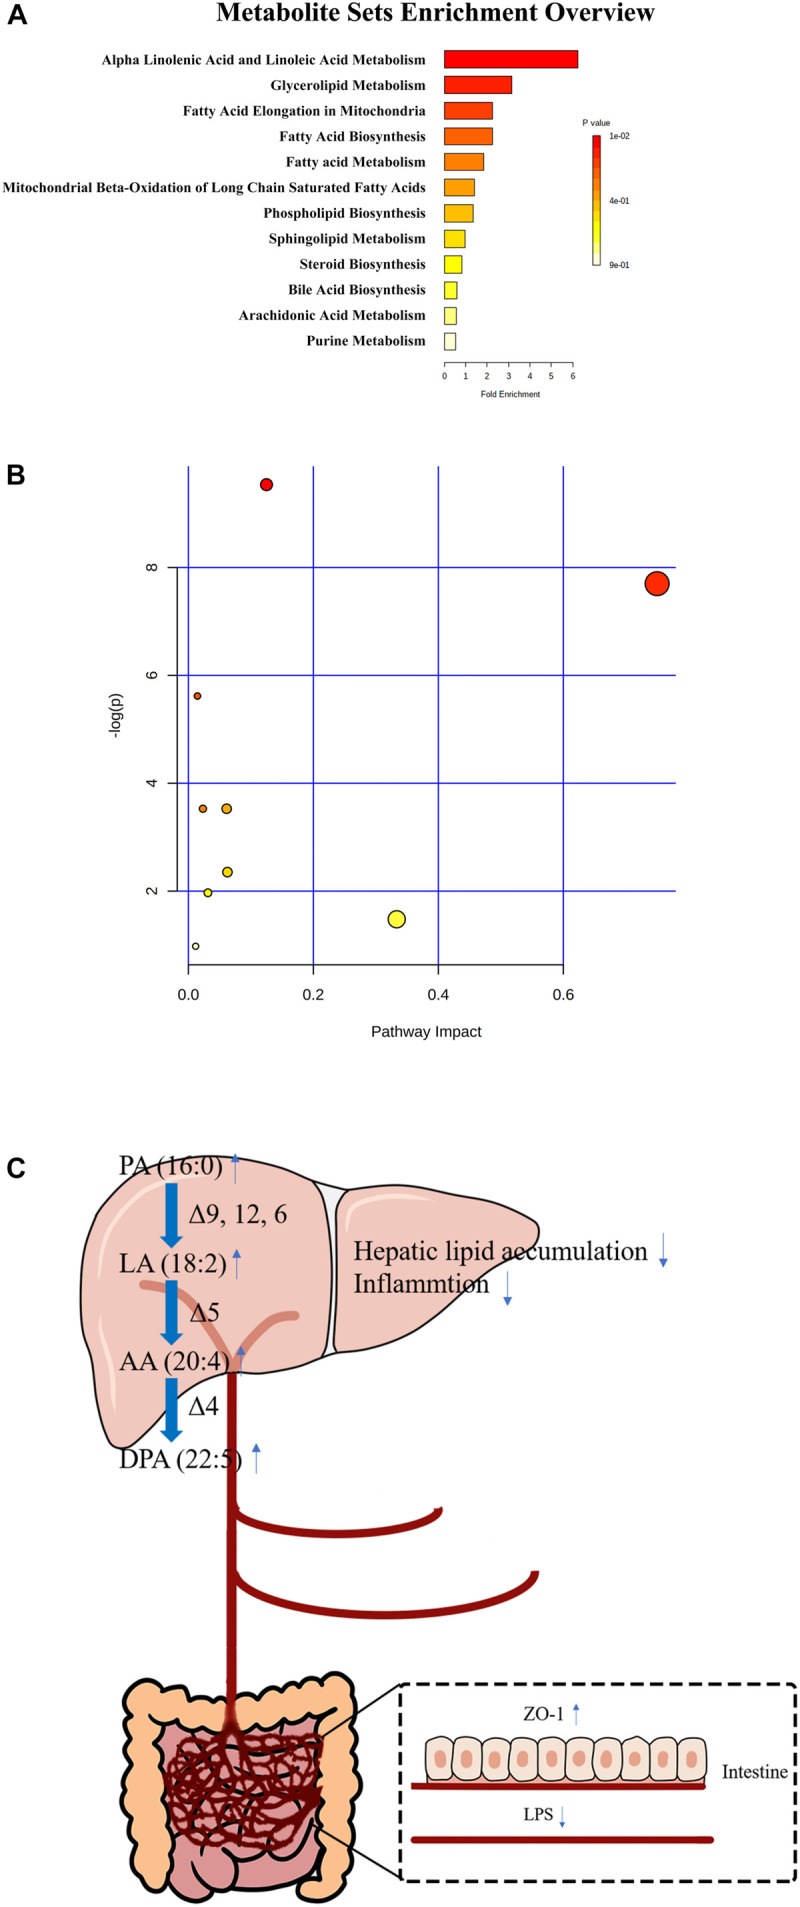
The enriched KEGG pathways (A,B) and the diagram of the protective effect of L. reuteri on ALD (C).